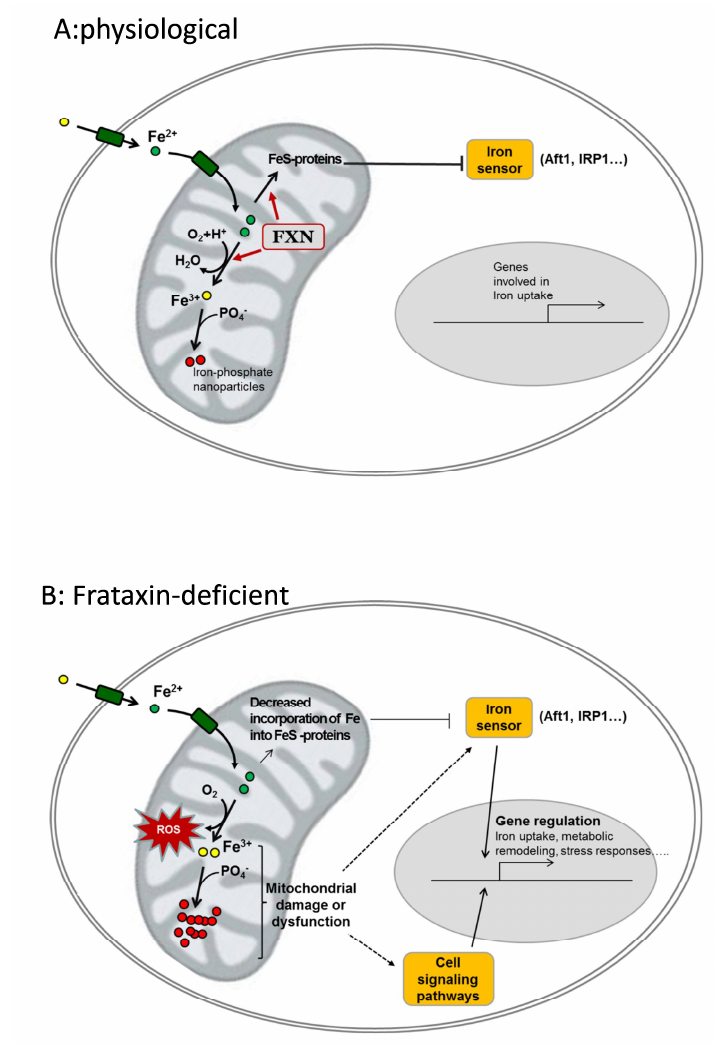
Figure 2. Potential contribution of frataxin to iron homeostasis and cellular consequences of its deficiency. ( A ), physiological: frataxin (FXN) binds Fe 2+ and contributes to its controlled oxidation